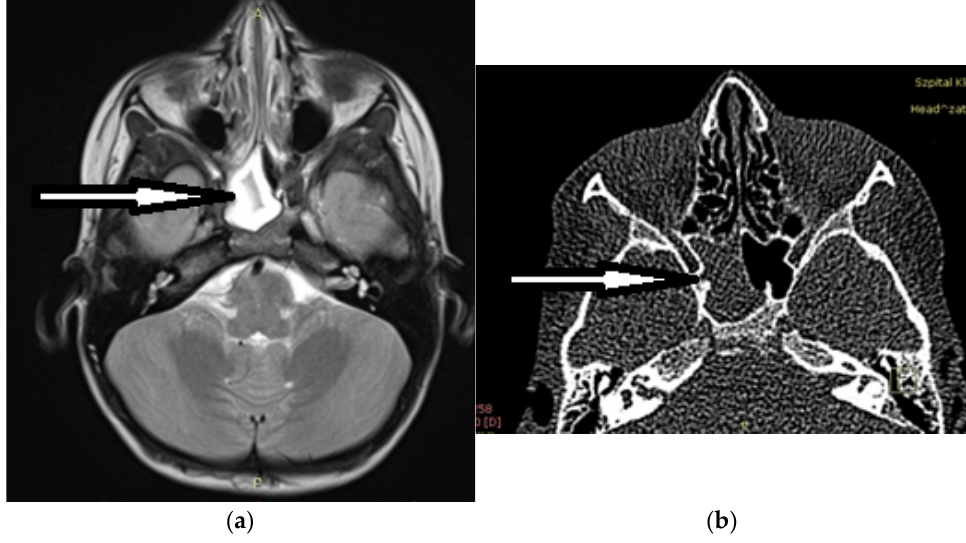
Figure 1. Isolated opacification of the right sphenoid sinus on imaging (arrows): ( a ) MRI T2; ( b ) CT.